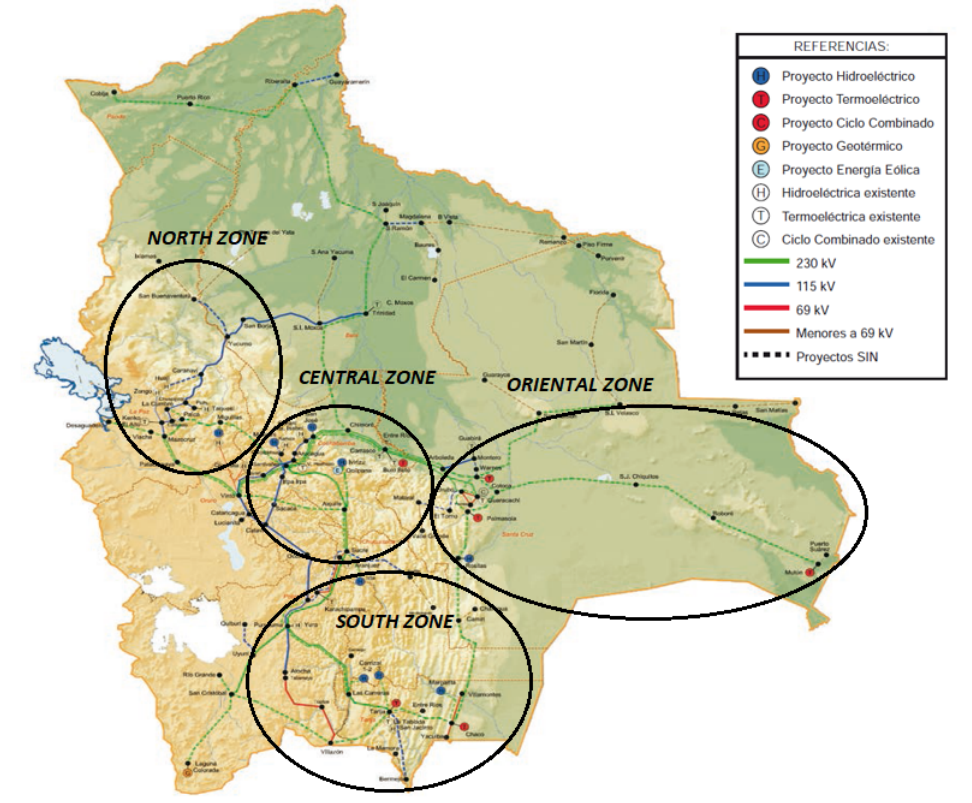
Figure 3. The SIN layout implemented and planned in the period 2020–2025 [35]. The transmission system is composed of transmission lines with high levels of voltage: 69 kV, 115 kV and 230 kV. This transmission lines shape the main power system grid known as STI (Sistema Troncal